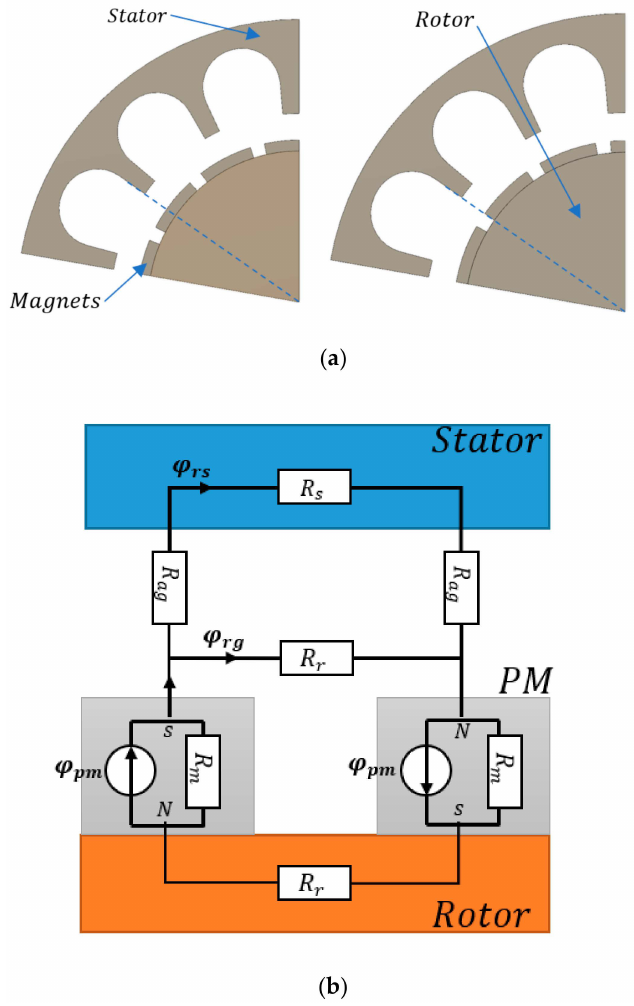
Figure 1. ( a ) By changing the angular position, the caves see di ff erent configurations. ( b ) Equivalent magnetic circuit. PM: permanent